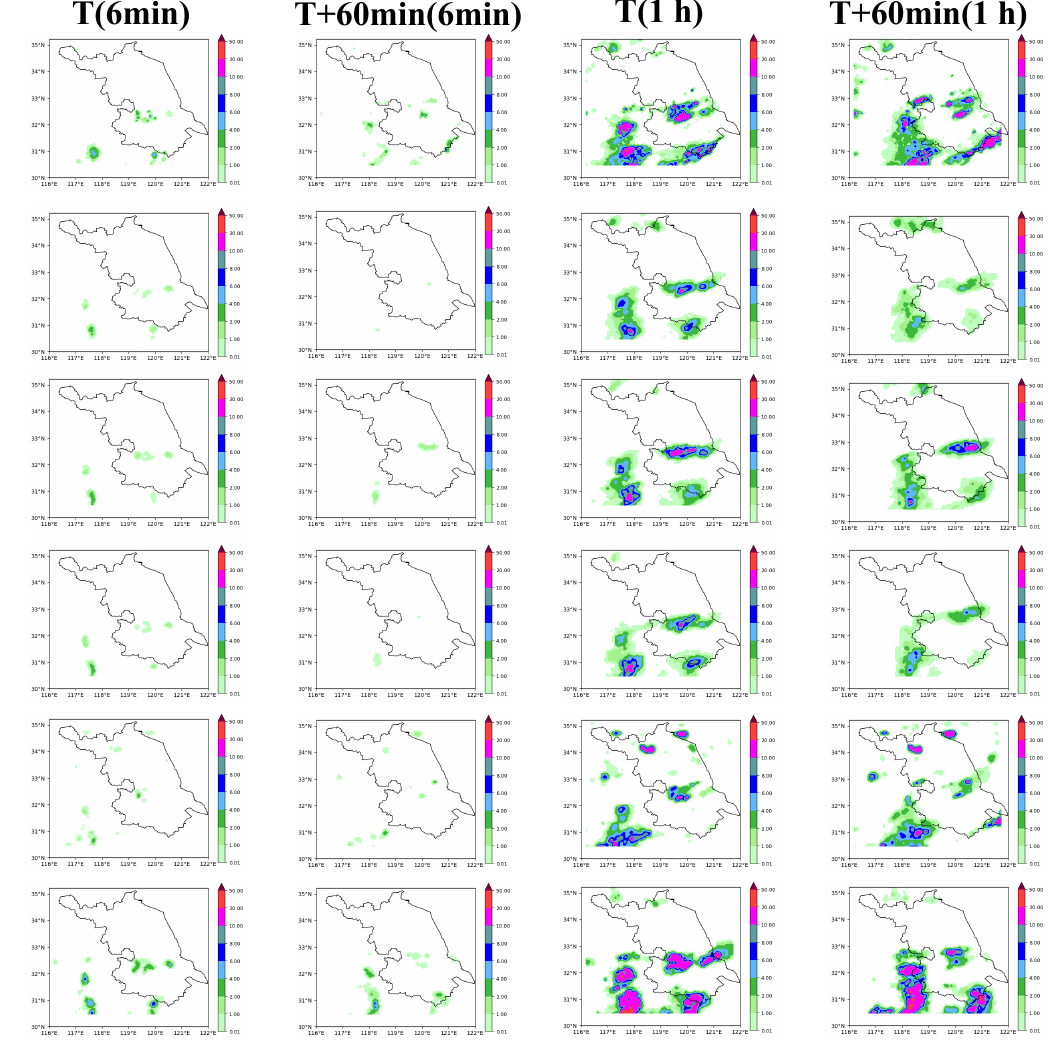
Figure 8. Visual comparison with other SOTAs results. The first row is the ground truth, and the last row is the effect of our model. The first column of each row is the 6-minute cumulative precipitation from time T to time T + 6 min, the second column is the 6-minute cumulative precipitation from time T + 60 min to time T + 66 min, the third column is the 1-h cumulative precipitation from time T to time T + 60 min, and the fourth column is the 1-h cumulative precipitation from time T + 60 min to time T + 120